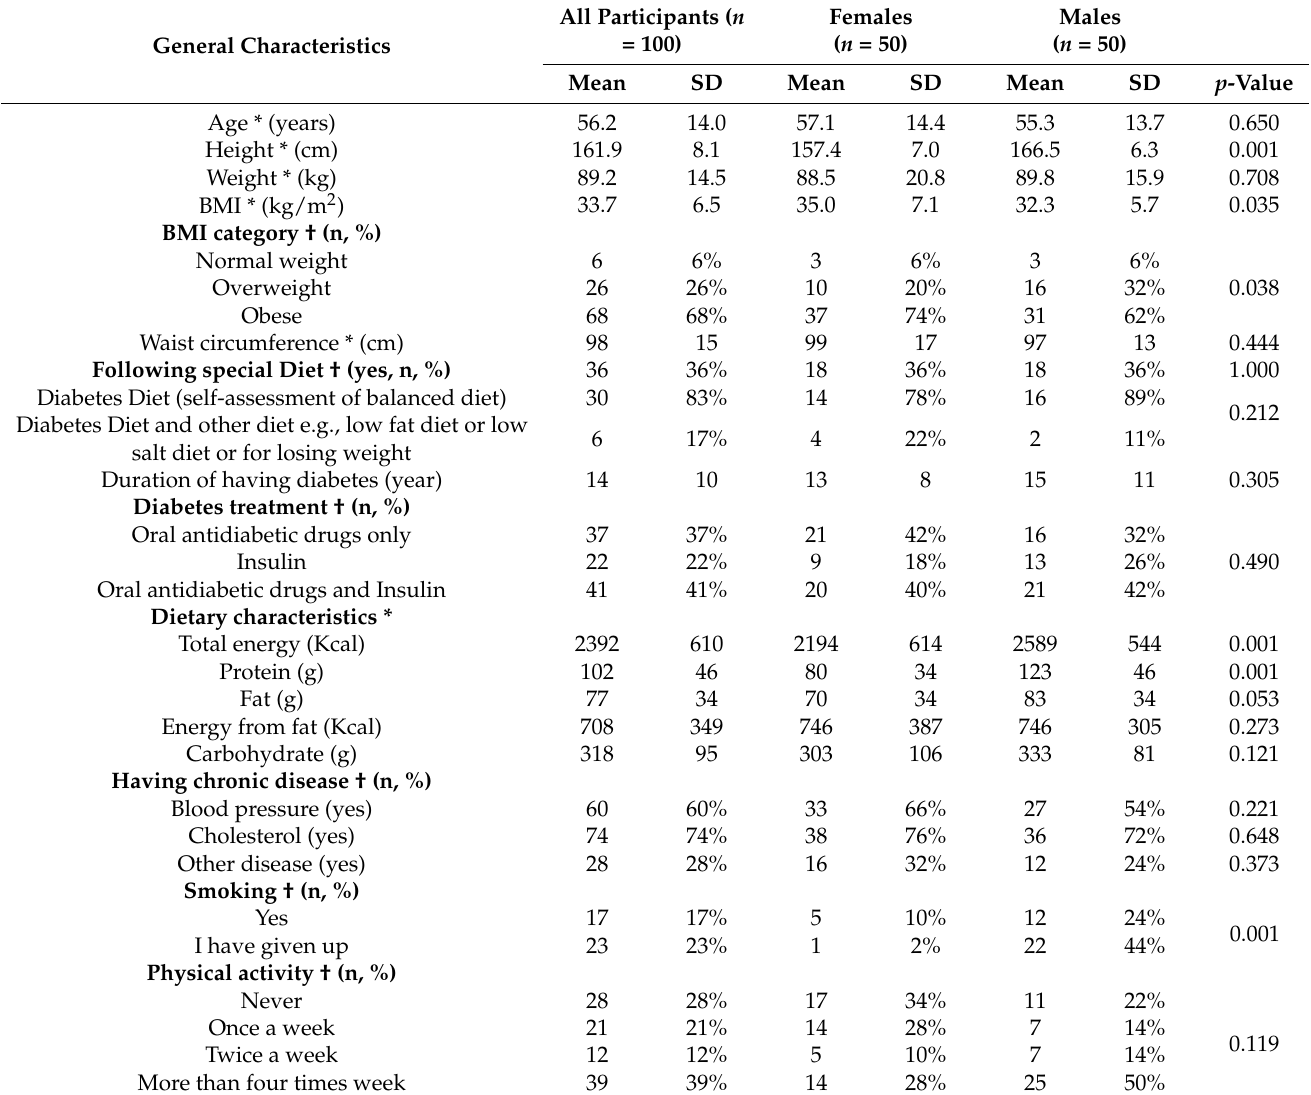
Table 1. General characteristics of study participants by